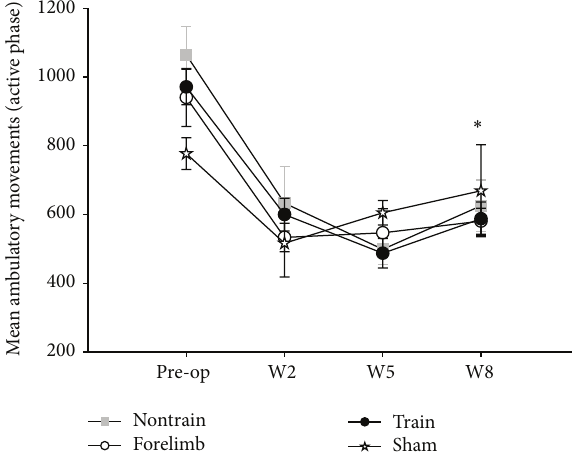
Figure 6: Home cage activity: in-cage activity assessments with an infrared activity monitor show no differences in the amount of ambulatory movements up to week 8 (W8), suggesting that the increased locomotor recovery of the trained group was a result of the step training paradigm and not due to “self-training.” All animals significantly decreased activity with time from surgery ( ∗ preoperation versus W8 for each group; repeated ANOVA with Bonferroni post hoc 𝑡 -tests; nontrain 𝑛 = 7 ; train 𝑛 = 13 ; forelimb 𝑛 = 9 ; sham 𝑛 = 4